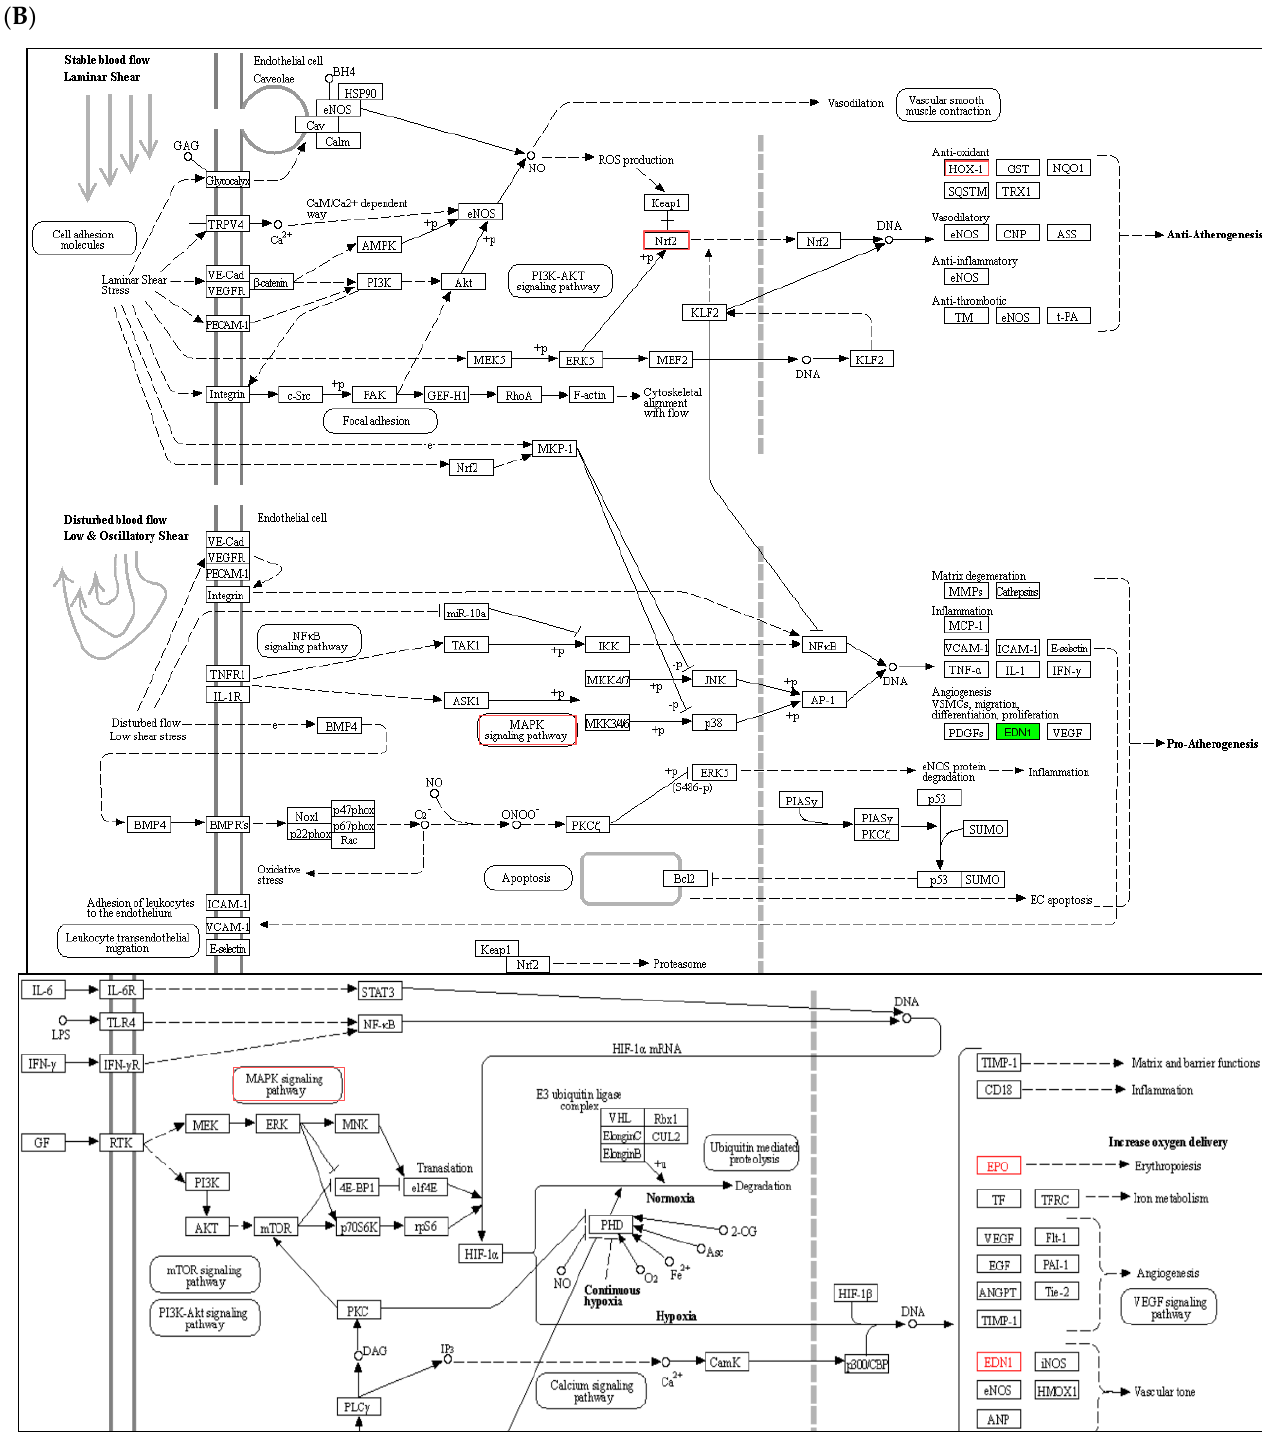
Figure 4. Kyoto Encyclopedia of Genes and Genomes (KEGG) of differentially expressed genes between different groups using RNA sequencing. The top 10 ranging KEGG pathways of the differentially expressed genes ( A ). The representative maps in KEGG analysis of the corresponding genes with differentially expressed genes exposed to H 2 O 2 /LBLF ( B ). Bar graphs CK-HP and HP-LBLF showing the KEGG terms for the differentially expressed genes among control group (CK), 150 µ M H 2 O 2 (HP), and 150 µ M H 2 O 2 and 100 µ g/mL LBLF-cotreated group (LBLF).